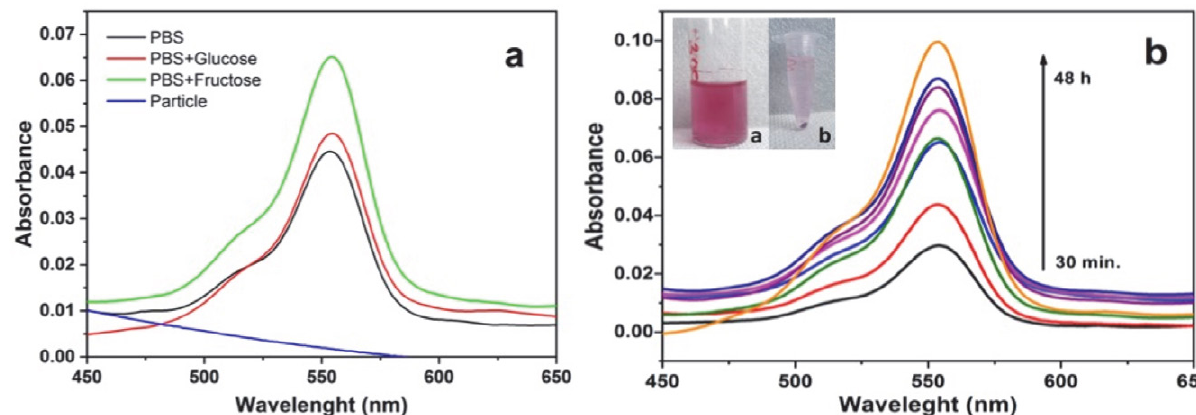
Figure 6. Absorbance spectra of P-P-3 sample after 2 h in a) PBS, PBS+10 mg/mL glucose, and PBS+10 mg/mL fructose environments, b) time de- pendent increase of dye release in PBS+10 mg/mL fructose environment (insets in (b) shows the digital images of the solution after releasing of Rhodamine B dye by the particles (left) and the collected particles with centrifuging